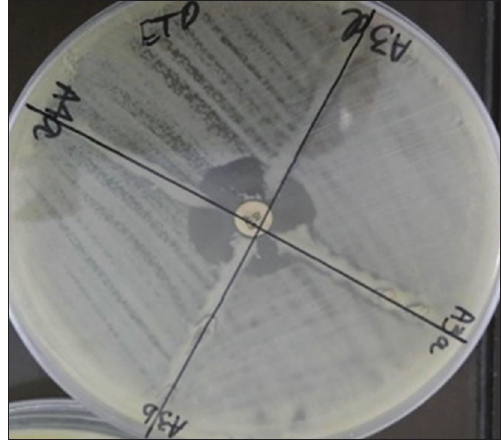
Figure-2: Modified Hodge test showing cloverleaf like indentation within the zone of inhibition of ertapenem